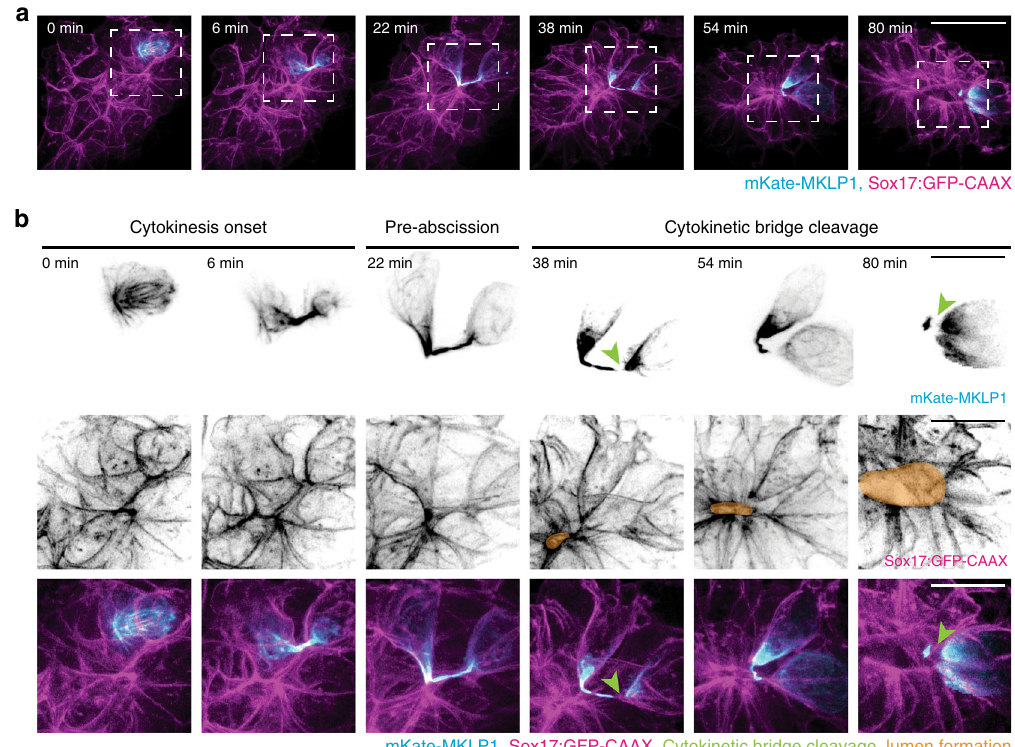
Fig. 3 Cytokinetic bridges are placed at the site of future KV lumen formation. a A 3D rendering of a cell (mKate-MKLP1, cyan) dividing within KV (Sox17:GFP-CAAX, magenta) over time. Bar, 20 μ m. b Cell within KV highlighted during cytokinesis onset (left), pre-abscission (center), and cytokinetic bridge cleavage (right). Region denoted with dashed line in a are shown in b . mKate-MKLP1 (top) and Sox17:GFP-CAAX (bottom) shown in grayscale and in merge below (mKate-MKLP1 in cyan, Sox17:GFP-CAAX in magenta). Green arrowhead denotes the locations of cytokinetic bridge cleavage; orange regions indicate lumen location. Bars, 10 μ